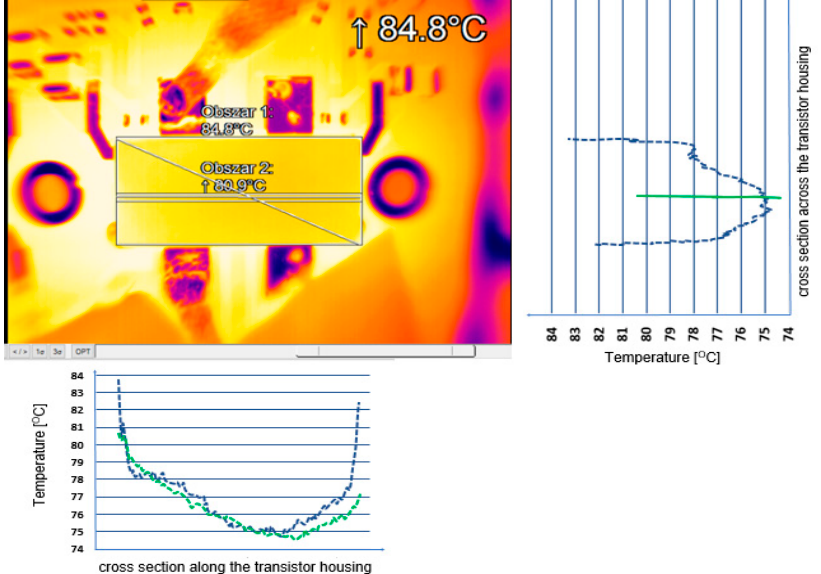
Figure 13. Thermogram and the case temperature distribution for the BLC10G22LS-240PVT transistor with the dissipated power P D = 21